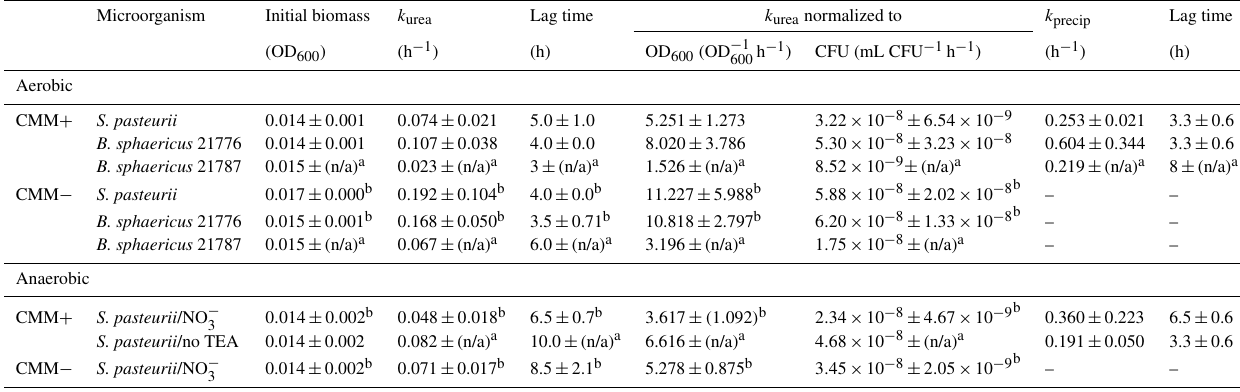
Table 2. Summary of kinetic parameters for urea hydrolysis ( k urea ) and calcite precipitation ( k precip ) in aerobic and anaerobic experiments in calcium-inclusive (CMM + ) and calcium-exclusive (CMM − ) experiments inoculated with S. pasteurii , B. sphaericus 21776 and B. sphaeri- cus 21787. Anaerobic experiments were incubated with or without nitrate as the terminal electron acceptor (TEA). Results are averages from triplicate experiments unless stated otherwise.